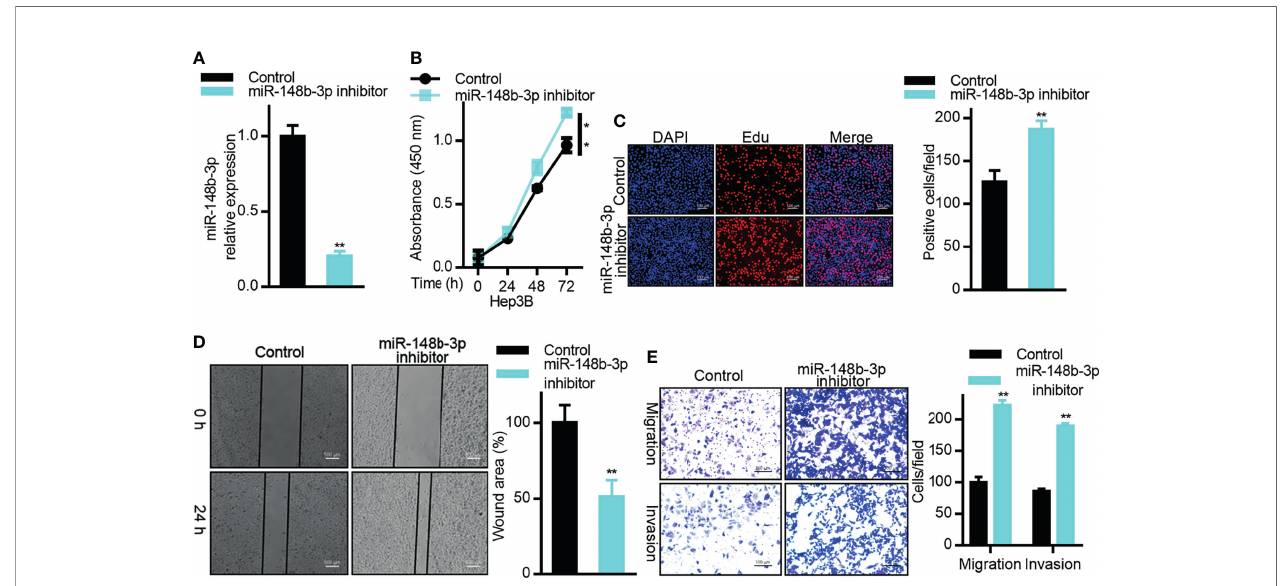
FIGURE 4 | MiR-148b-3p functions as a tumor suppressor in HCC. (A) miR-148b-3p expression was assessed in Hep3B cells transfected with a miR-148b-3p inhibitor. (B) The proliferation of cells treated as in (A) was assessed via CCK-8 assay and via (C) EdU incorporation staining assay. Scale bar, 100 m m. (D) A wound healing assay was used to assess the migration of cells treated as in (A) . Scale bar, 500 m m. (E) The migratory and invasive activity of cells treated as in (A) was assessed via Transwell assay. Scale bar, 100 m m. Data are means ± SD. * p < 0.05; ** p < 0.01; Student ’ s t-tests.